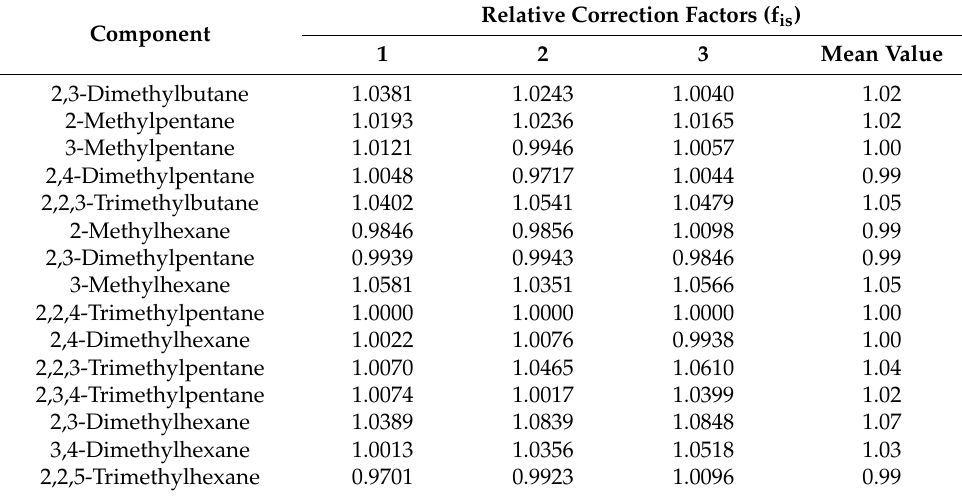
Table 1. Relative correction factors for the components.